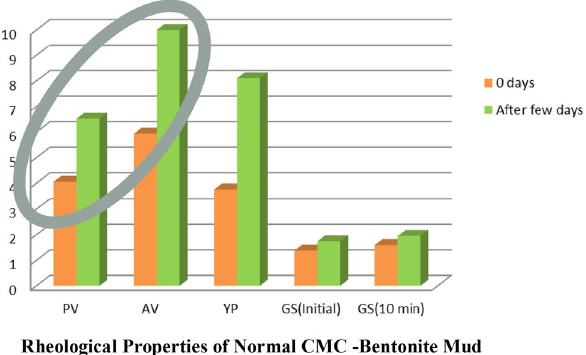
Fig. 26 Rheological properties of non-optimized CMC–bentonite mud in accordance with